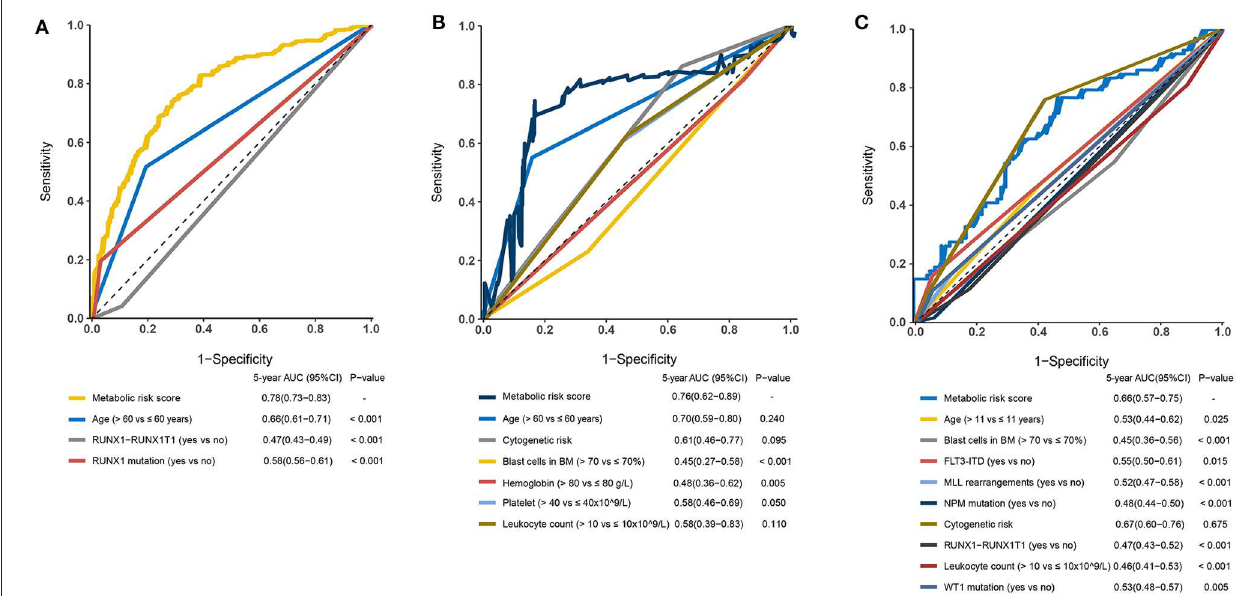
FIGURE 6 | Time-dependent receiver operating characteristic (ROC) analysis of 5-year overall survival (OS) of metabolic risk model compared to other potential prognostic factors. (A) Time-dependent ROC analysis for 5-year OS of metabolic risk model was compared to age, RUNX1-RUNX1T1 , and RUNX1 mutation in the training cohort. (B) Time-dependent ROC analysis for 5-year OS of metabolic risk model was compared to age, cytogenetics risk, blast cells in bone marrow, hemoglobin, platelet, and leukocyte count in the adult external cohort. (C) Time-dependent ROC analysis for 5-year OS of metabolic risk model compared to age, blast cells in the bone marrow, cytogenetics risk, RUNX1 - RUNX1T1 fusion, FLT3 - ITD status, MLL -rearrangement, NPM mutation, leukocyte count, and WT1 mutation in the pediatric external cohort. BM, bone